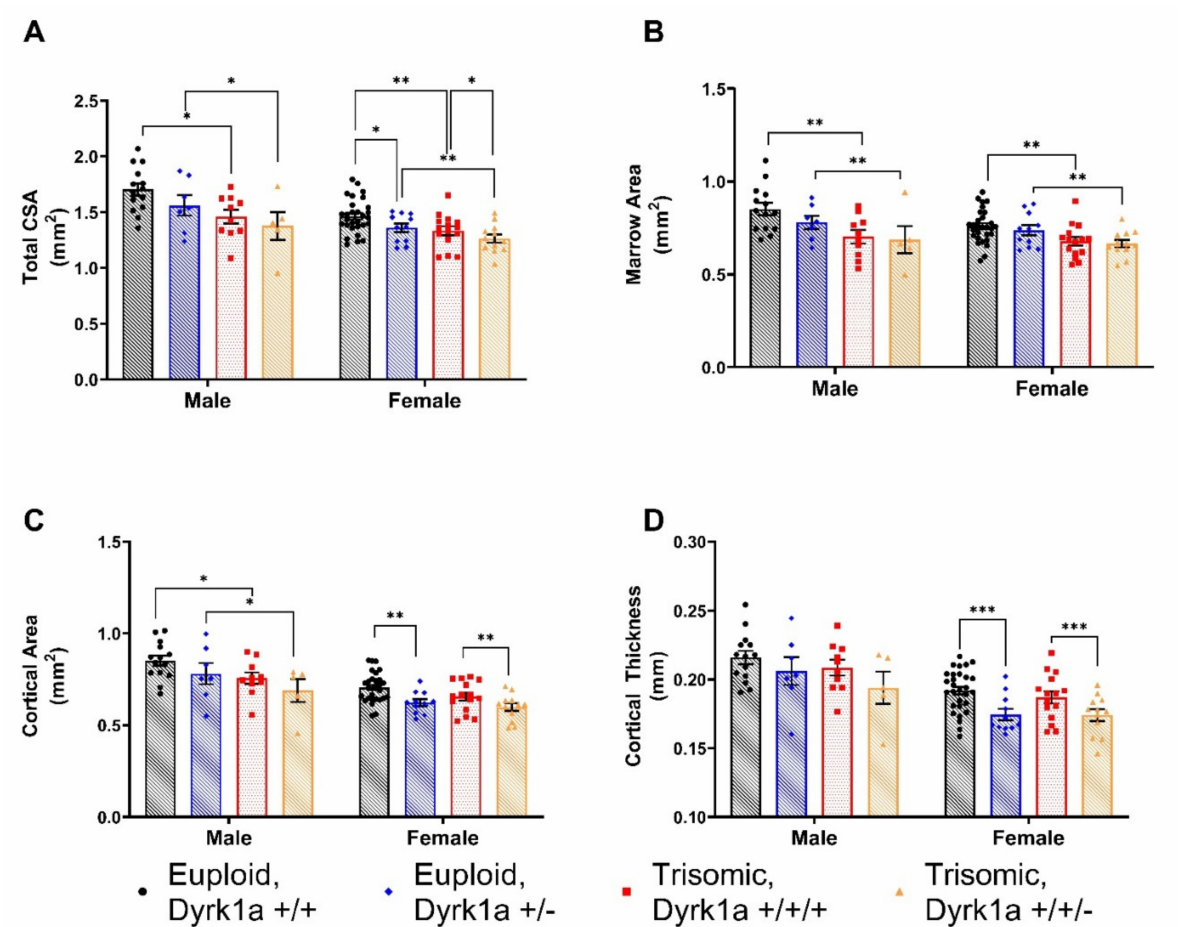
Figure 2. Cortical bone parameters are significant different between male and female Euploid and Ts65Dn animals ( A – D ). ( A ) Total cross-sectional area (CSA) main of effect of ploidy in males and main effect of ploidy and Dyrk1a genotype in females. ( B ) Marrow Area (Ma.Ar); main effect of ploidy in male and female animals. ( C ) Cortical Area (Ct.Ar); main effect of ploidy in male mice; main effect of Dyrk1a copy number in female. ( D ) Cortical Thickness (Ct.Th); main effect of Dyrk1a copy number in female animals. Mean ± SD; bars between groups of mice denote significance; p -value 0.1234 (ns); 0.0332 (*); 0.0021 (**); 0.0002